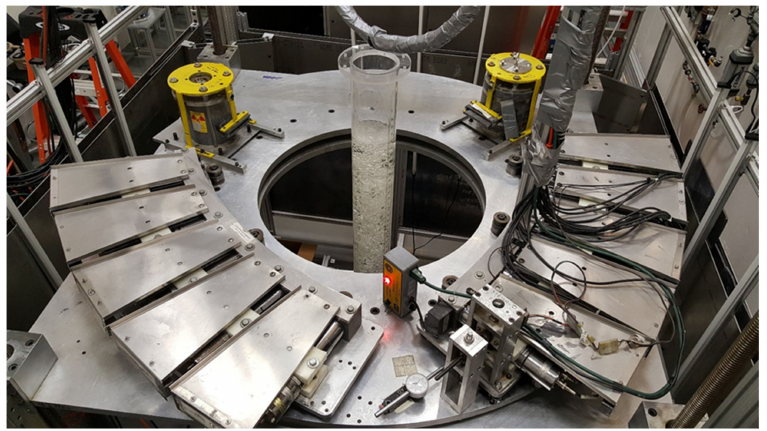
Figure 2. Picture of dual-source gamma-ray computed tomography technique and split-plate airlift reactor.